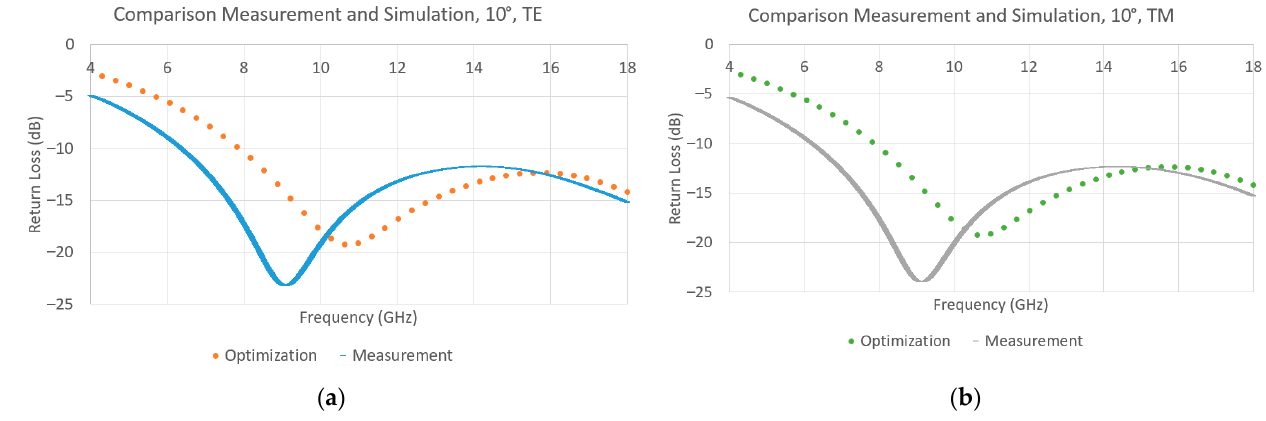
Figure 12 . Result of the measurement of the multilayer between 4 GHz and 18 GHz and comparison with the simulation of the optimized structure at 10°, ( a ) TE, ( b )